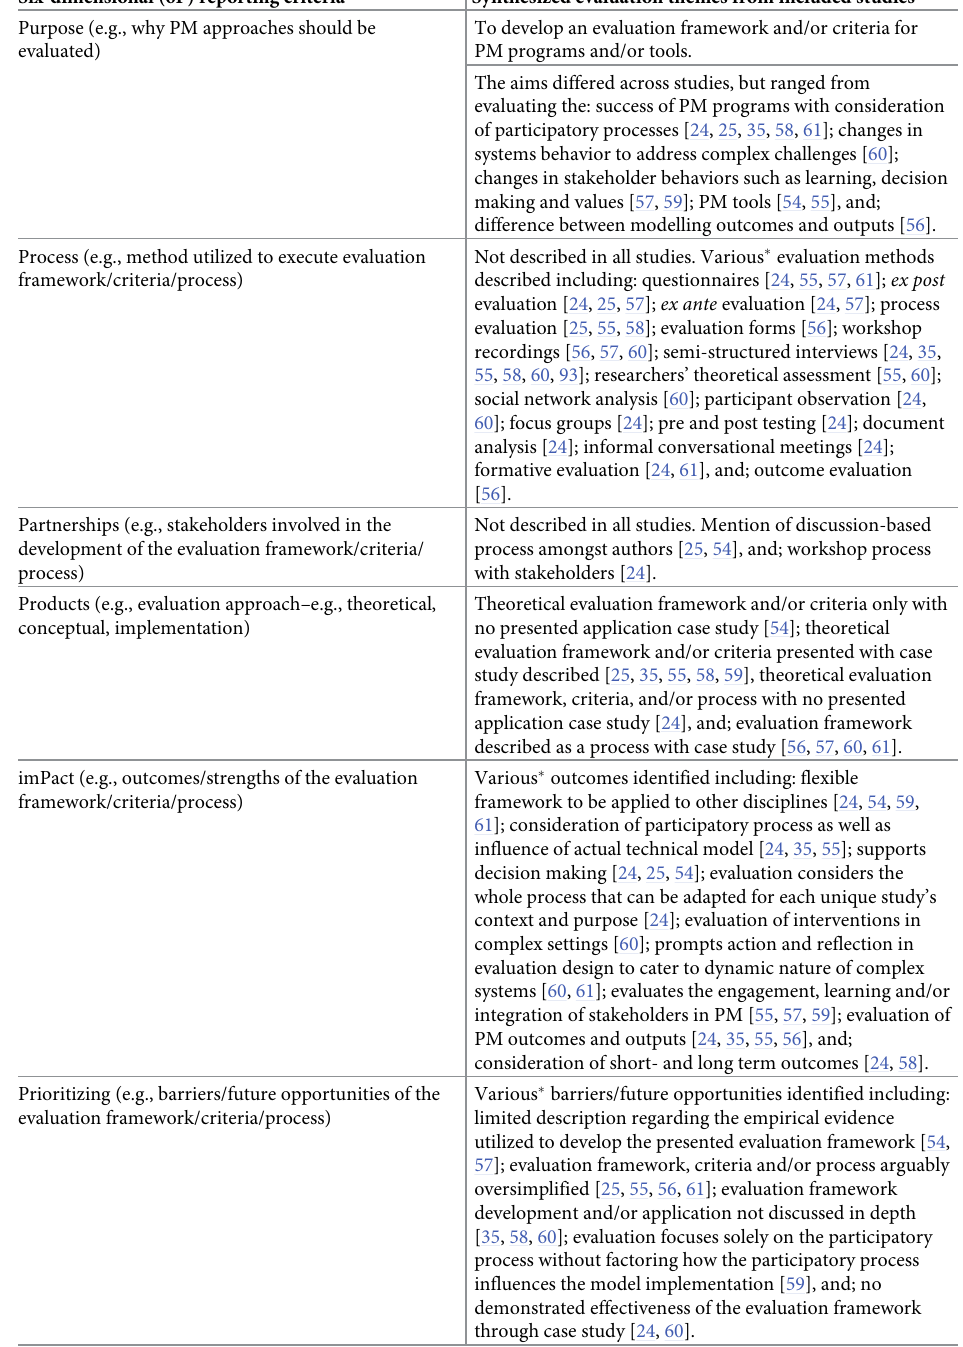
Table 6. Recurring themes synthesized via Freebairn’s adapted six-dimensional (6P) communications framework that standardize the reporting of PM